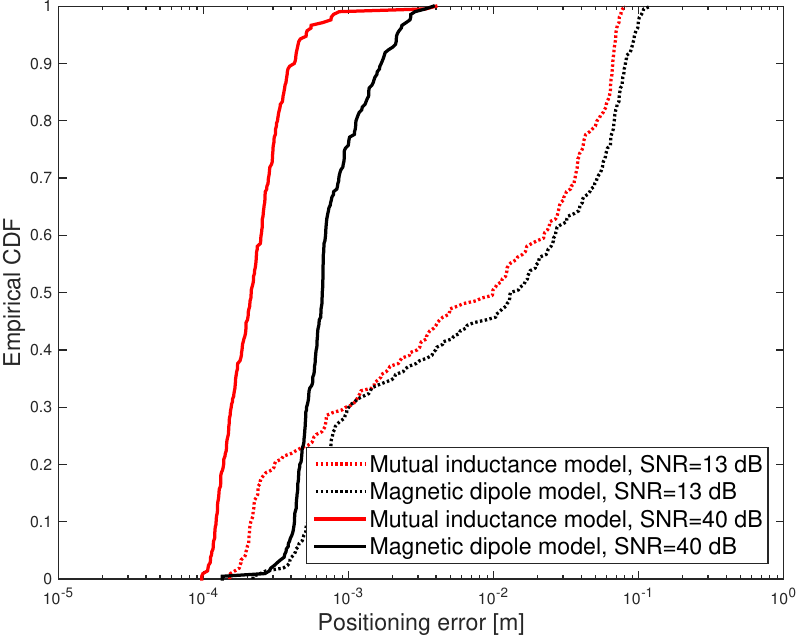
Figure 5. Simulation results: CDF of the positioning error obtained for SNR = 13 dB and SNR = 40